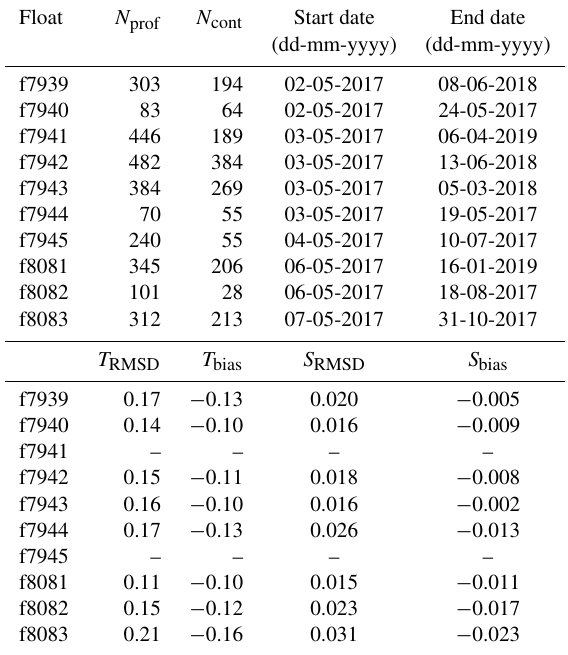
Table 1. Float number, total number of profiles measured by each float ( N prof ) and subset of profiles measured in continuous mode ( N cont ), date of first and last transmitted profile, and RMSD and bias of float temperature ( ◦ C) and salinity relative to ship